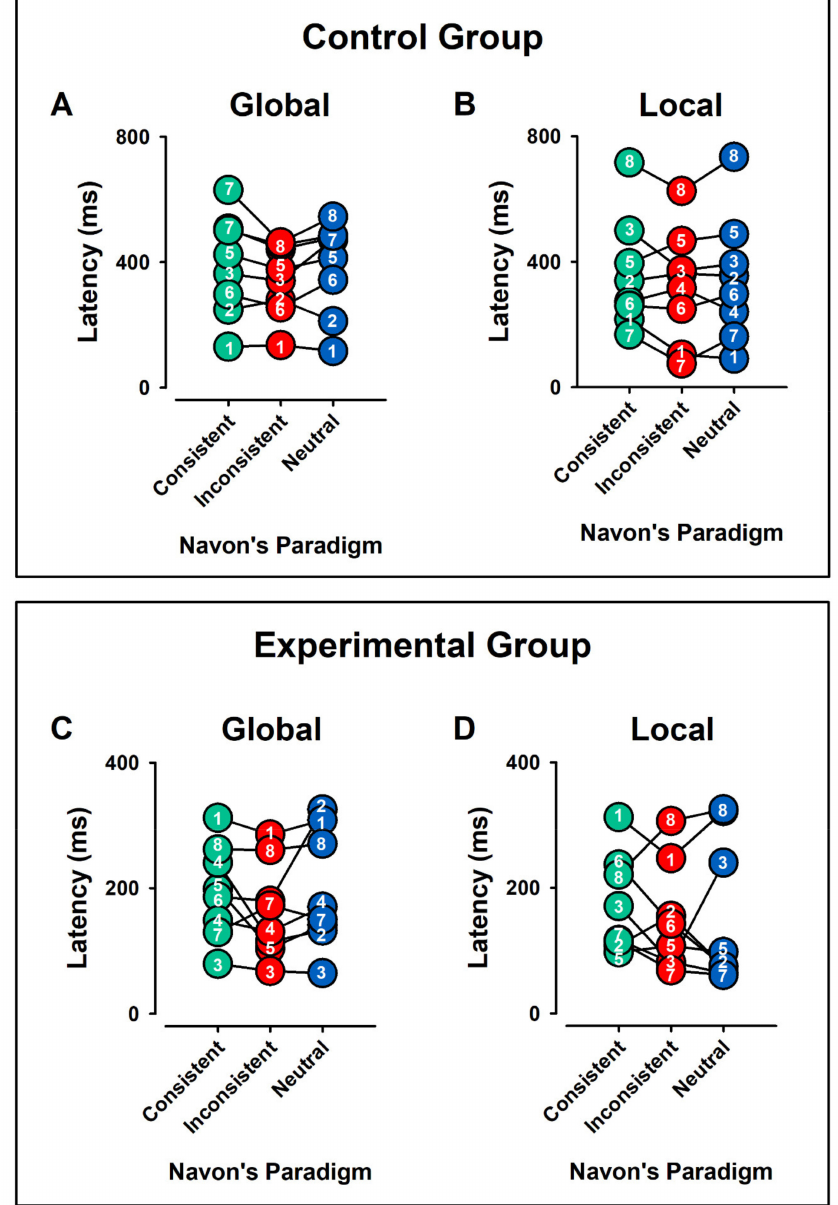
Figure 8. Pooled data of latencies for all individuals in Global ( A , C ) and Local ( B , D ) Aspect Recog- nition for control and experimental groups, respectively. The individual values for each subject are represented with a number. In each case, the consistent, inconsistent, and neutral conditions are displayed. Note the interindividual differences. We observed higher latencies in control group than in experimental